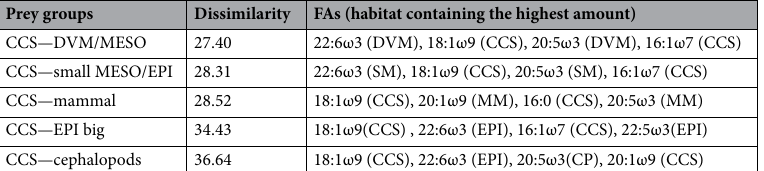
Table 2. SIMPER output of relative dissimilarity scores between Cookiecutter sharks (CCS) muscle FA profiles and prey group FA profiles. The top two FAs driving the dissimilarity are ordered by contribution, with the group containing the highest amount indicated in